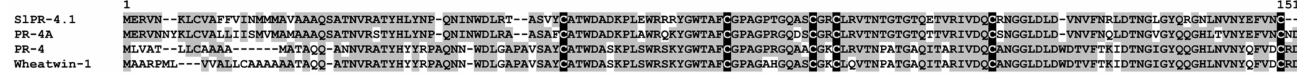
Figure 17. Multiple sequence alignment of S. lycopersicum PR-4 precursor and Nicotiana tabacum PR-4A (P29062.1), Hordeum vulgare pathogenesis-related protein 4 (PR-4) (KAE8805200.1), and T. aestivum wheatwin-1 (O64392.1). Cysteine residues are shaded black, and identical amino acids are shaded